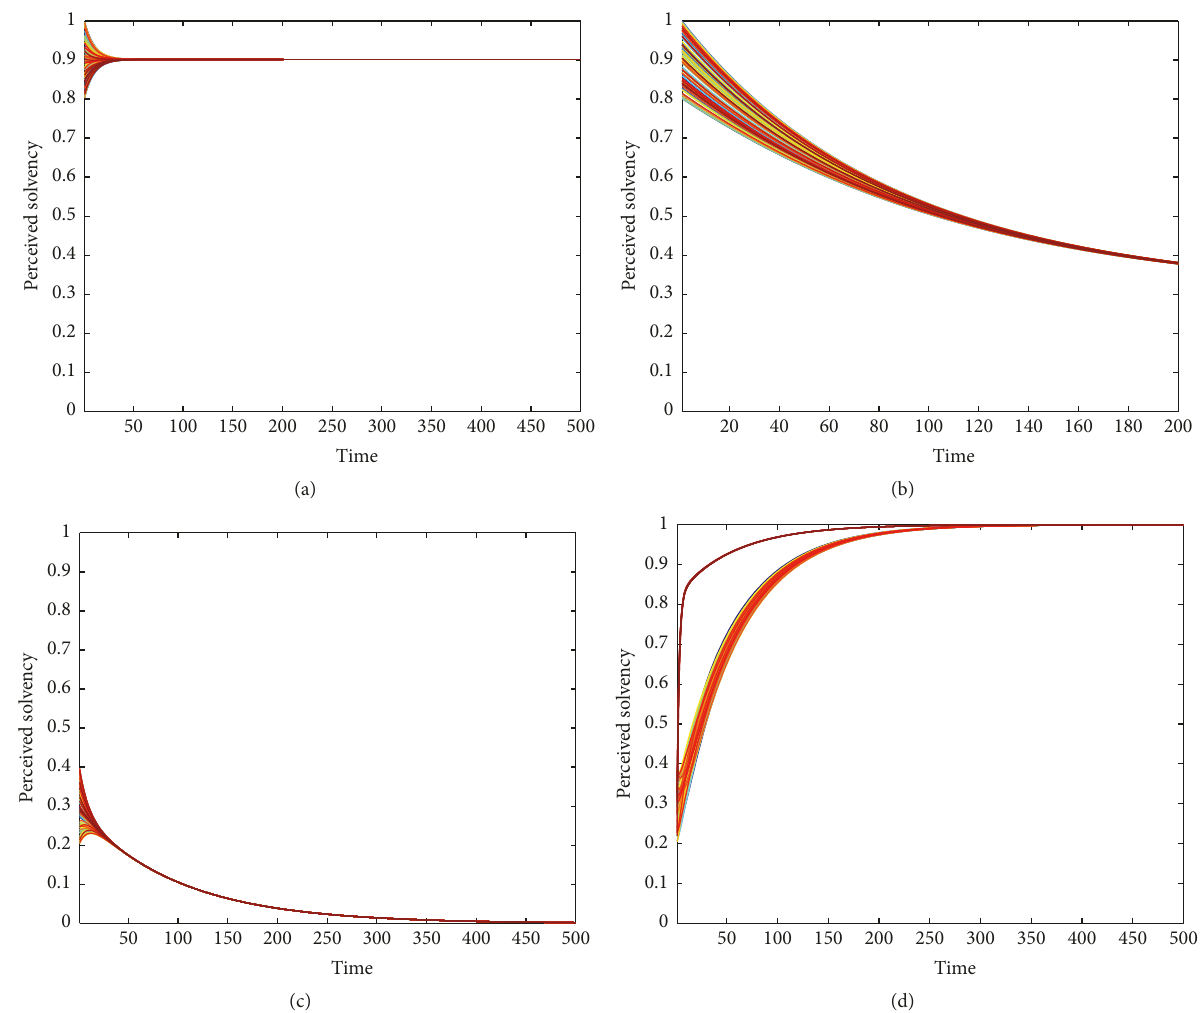
Figure 2: Four convergent processes ((a) presents the process without intervention in normal circumstances; (b) displays crisis extending; (c) shows no intervention when liquidity declines; (c) indicates bailouts in crisis).